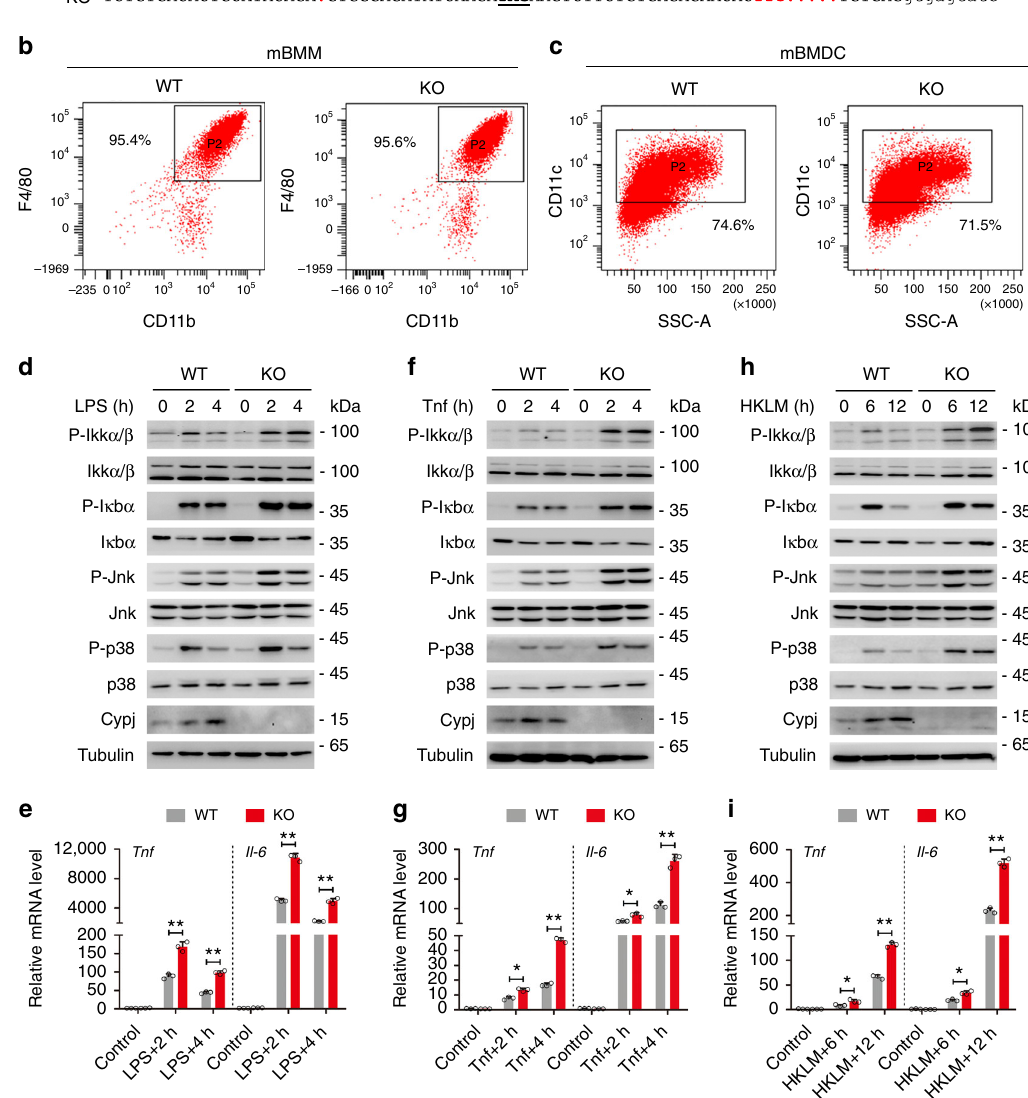
blocks classic NF- κ B signaling by acting downstream of TRAF6 and upstream of the IKK complex, and the TAK1-TAB complex is a potential target. The activation of TAK1-TAB protein complex stimulates a series of signal pathways including NF- κ B and AP- 1 25,29 . We then performed luciferase assays and revealed that CYPJ inhibited both the TRAF6 and TAK1-TAB1/2-activated AP-1 reporter (Supplementary Fig. 6). We carried out co-immunoprecipitation (co-IP) assays to screen for binding partners of CYPJ in NF- κ B signal pathway,